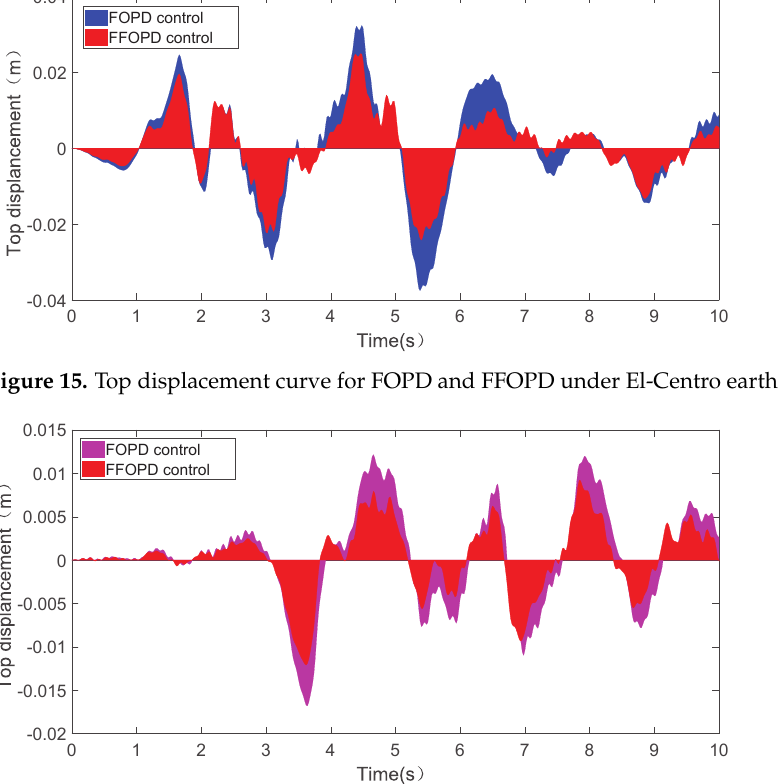
Figure 16. Top displacement curve for FOPD and FFOPD under Taft